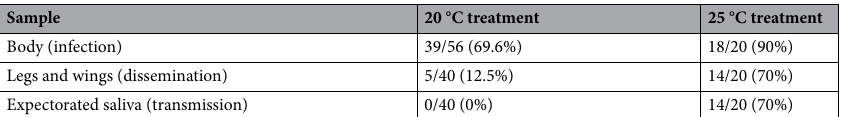
Table 1. The proportion of C. pipiens pipiens samples for which JEV RNA was recovered in both 20 °C and 25 °C treatments 14 days post inoculation. From the 70 mosquitoes sampled from the 20 °C treatment, 14 were sent for IHC analysis and during experimental manipulation 16 mosquitoes were damaged so that leg and wings, and saliva samples could not be obtained.